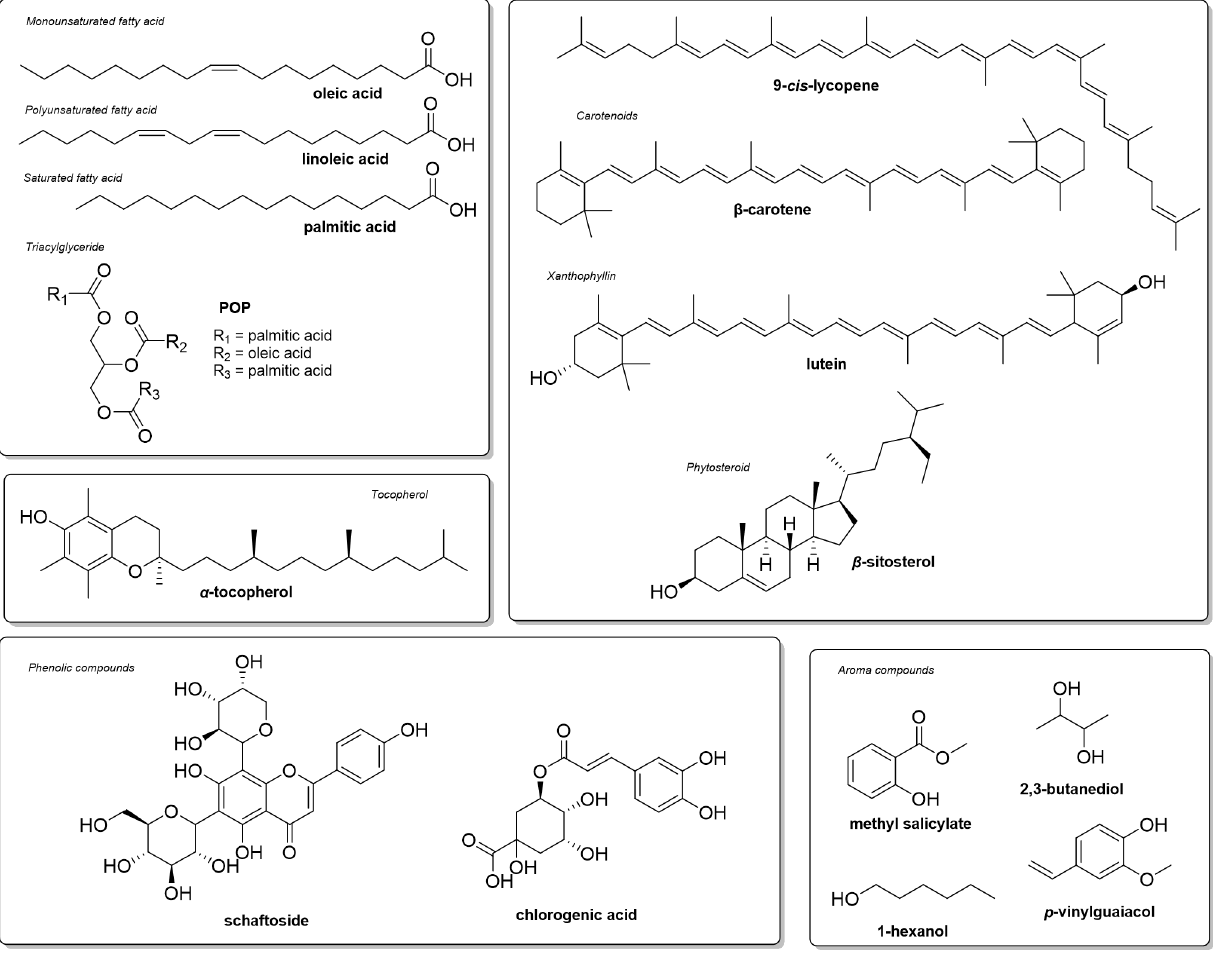
Figure 3. Chemical structures of the major metabolites described for the peach palm. Specialized Metabolites